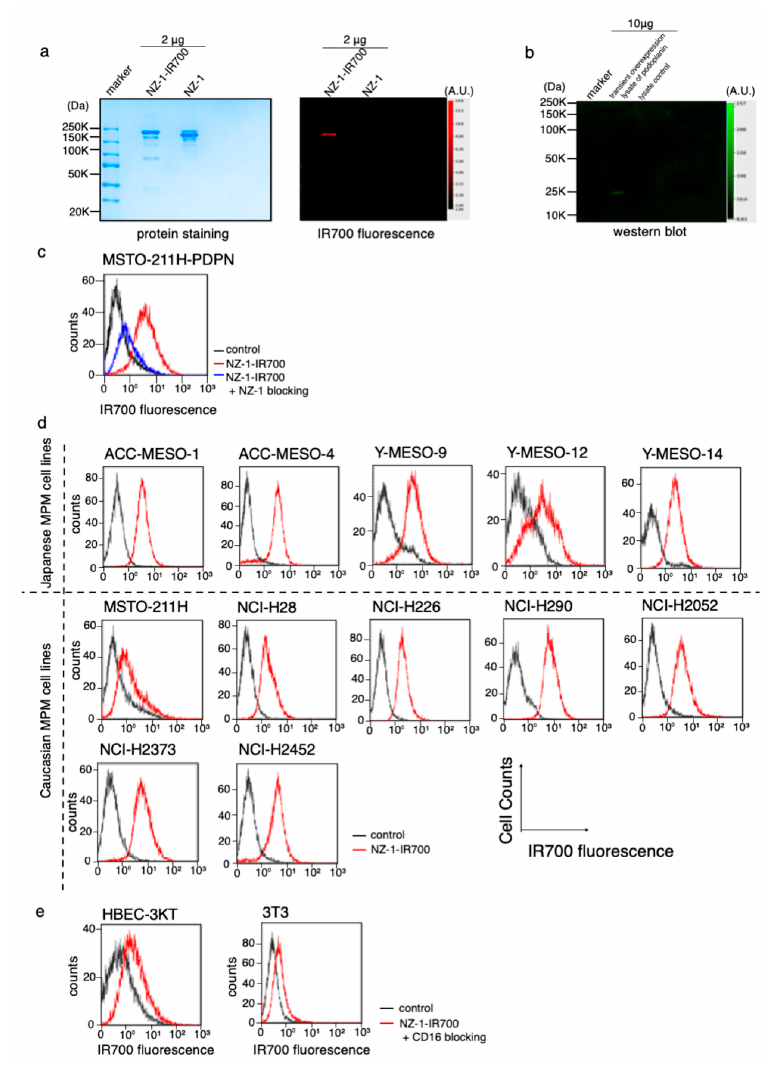
Figure 2. Conjugation of NZ-1-IR700 and its binding capacity. ( a ) Successful confirmation of conjugated NZ-1-IR700 with SDS-PAGE (left, colloidal blue staining; right, fluorescence at 700 nm channel). Diluted NZ-1 served as a control. ( b ) Immunoblotting with NZ-1-IR700 in PDPN-overexpressing cell lysates. Specific binding of NZ-1-IR700 to PDPDN was detected. ( c ) Prior incubation with excess NZ-1 (to block PDPN) inhibited the binding of NZ-1-IR700 to MSTO-211H-PDPN cells, indicating that NA-1-IR700 binds specifically to PDPN. ( d ) PDPN expression in various MPM cell lines. Examination of PDPN expression in MPM cell lines established from Caucasian and Japanese patients with MPM. Almost all MPM cell lines, except for Y-MESO-12 and MSTO-211H, expressed PDPN and showed IR700 fluorescence. ( e ) Flow cytometric analysis of NZ-1-IR700 in HBEC (normal bronchial epithelial cells) and mouse fibroblast 3T3 cells. Unspecific binding to normal or mouse fibroblasts was not